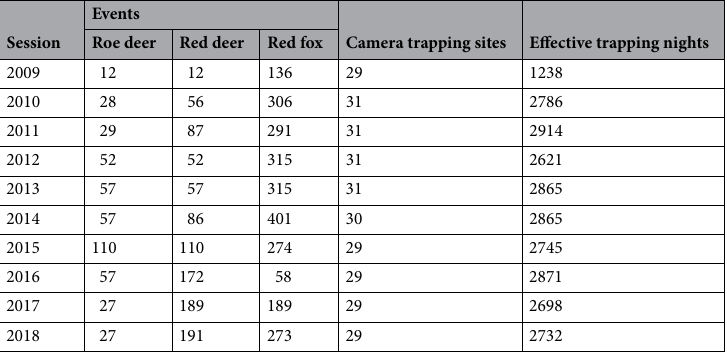
Table 3. Summary of the available information about roe deer, red deer and red fox obtained every primary period, including number of events, camera trapping sites and effective trapping nights. The number of events refers to the mean number of events resulting from all iterations in which one camera trap per site was sampled at a time.